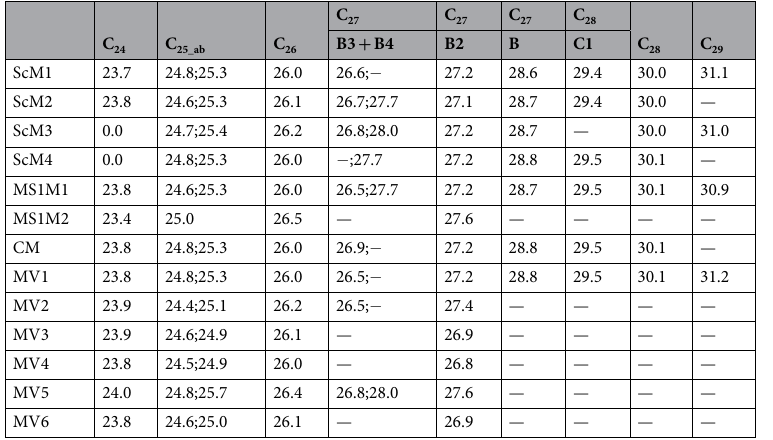
Table 2. Retention times (minutes) for the main chromophores of mauveine obtained from different historical and synthesized samples (MV1-6), at λ = 550